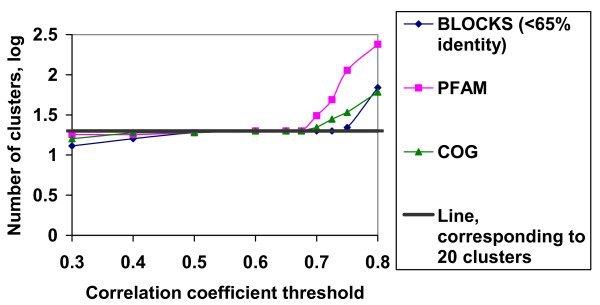
The number of clusters in the BLOCKS (<65% identity), PFAM and COG databases as a function of the correlation coefficient threshold employed in the clustering procedure. Note the horizontal region on the plot when the correlation coefficient threshold is between 0.5 and 0.65.